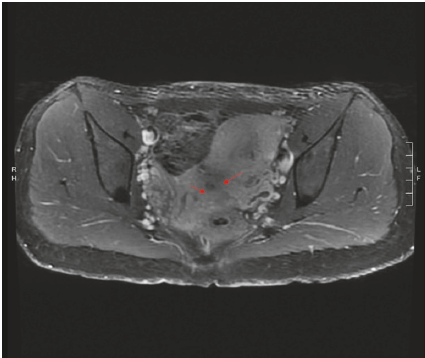
Figure 4: MRI demonstrating bicollis uterus.